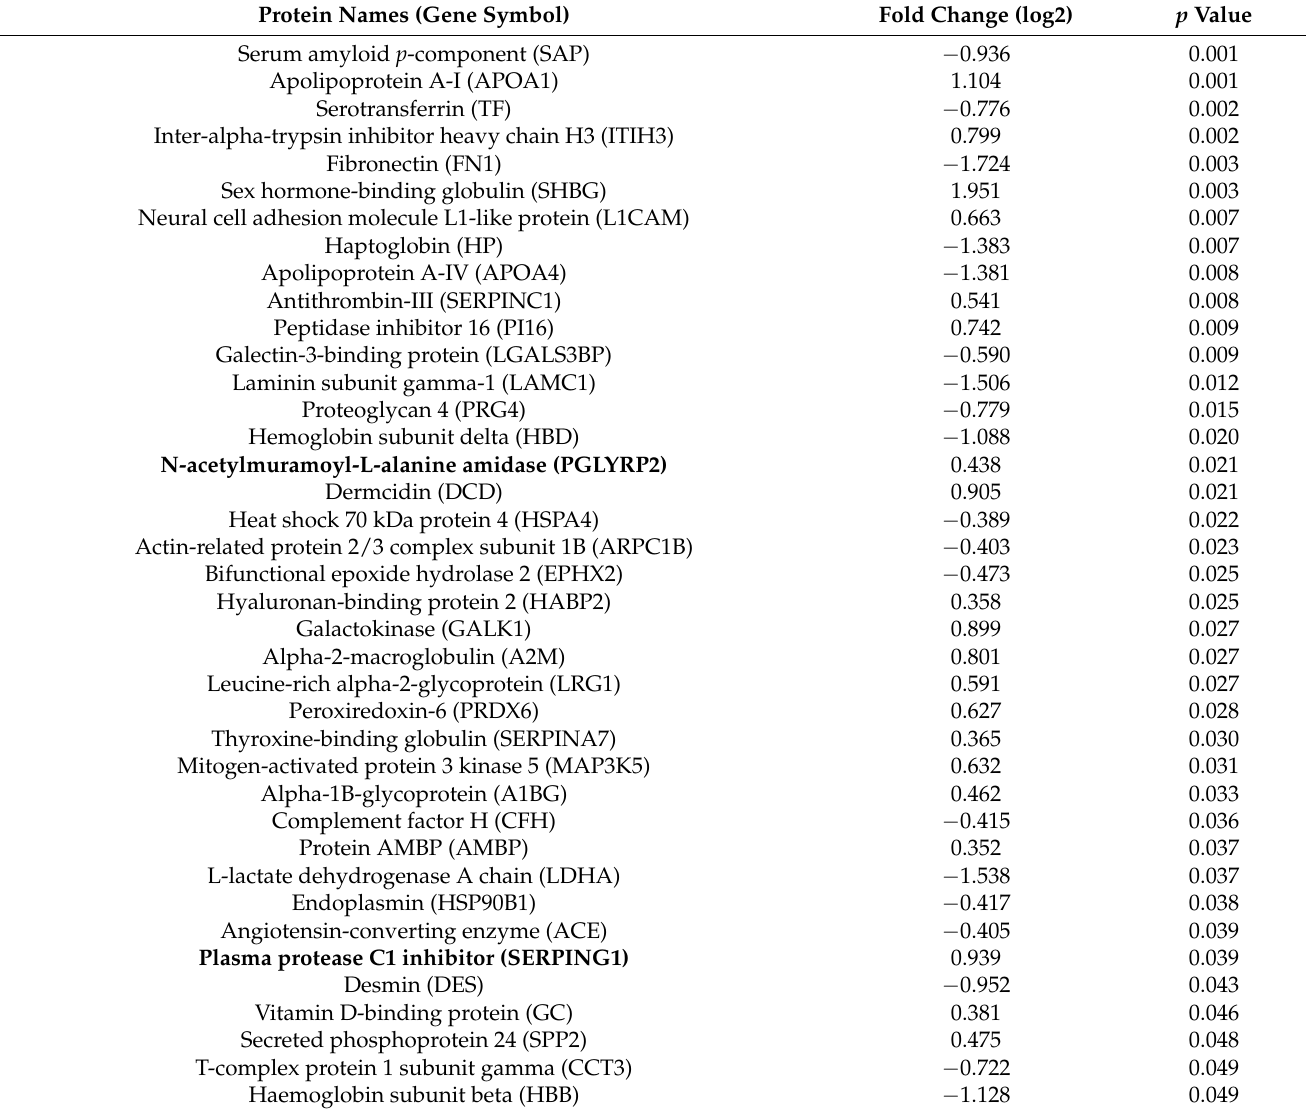
Table 3. Proteins showing a significant difference in expression between baseline and 12 months post-surgery. Protein Names (Gene Symbol) Fold Change (log2) p